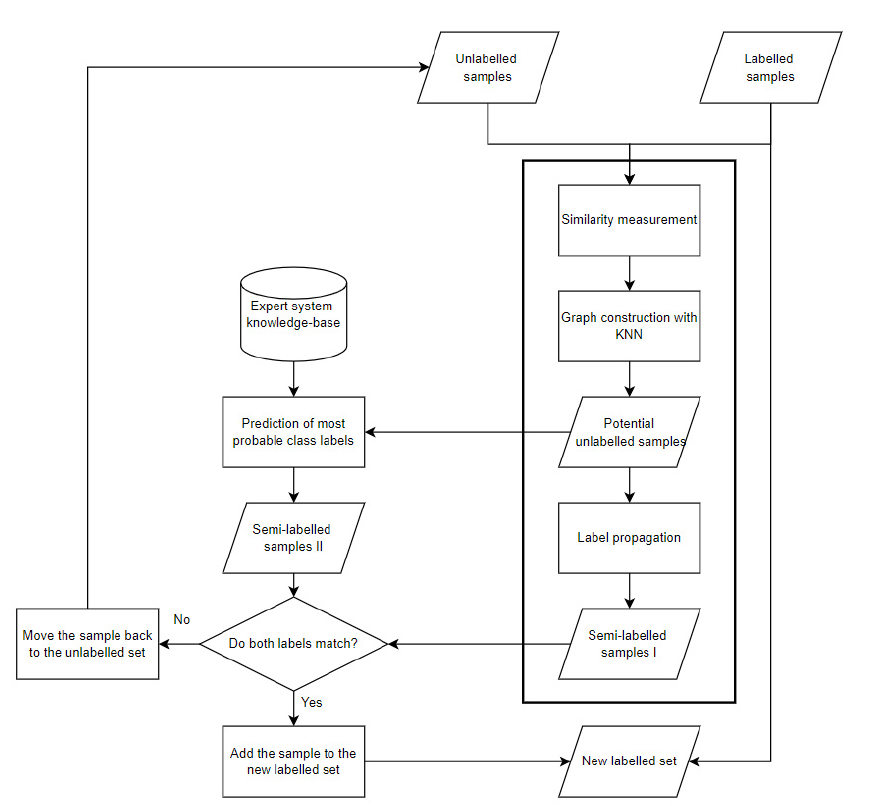
Figure 2. SSLES flowchart.